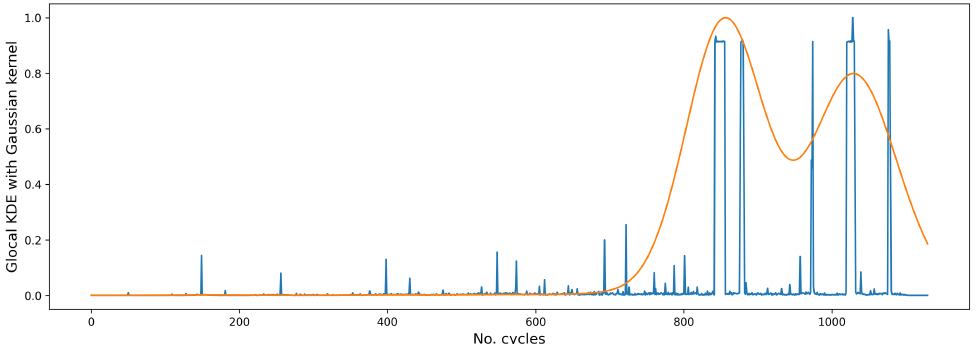
Figure 11. Gaussian kernel density estimation computed with the frontier extraction results of all four statistical parameters.